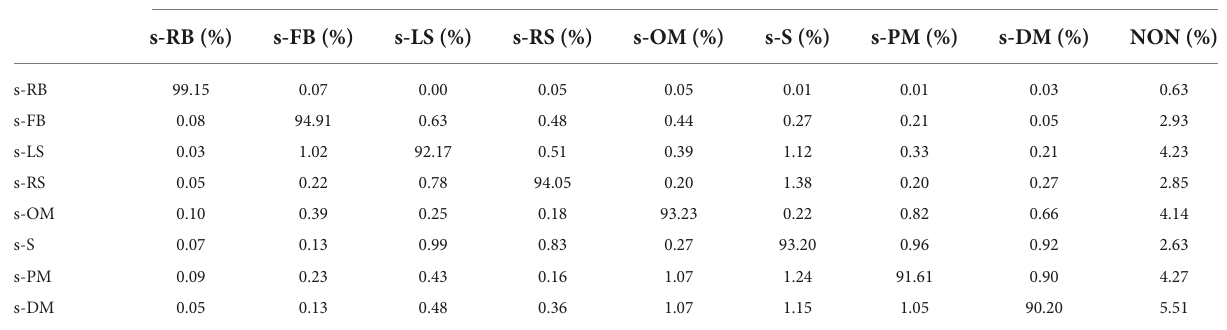
movements, the S7 opened the electrical gripper to put down